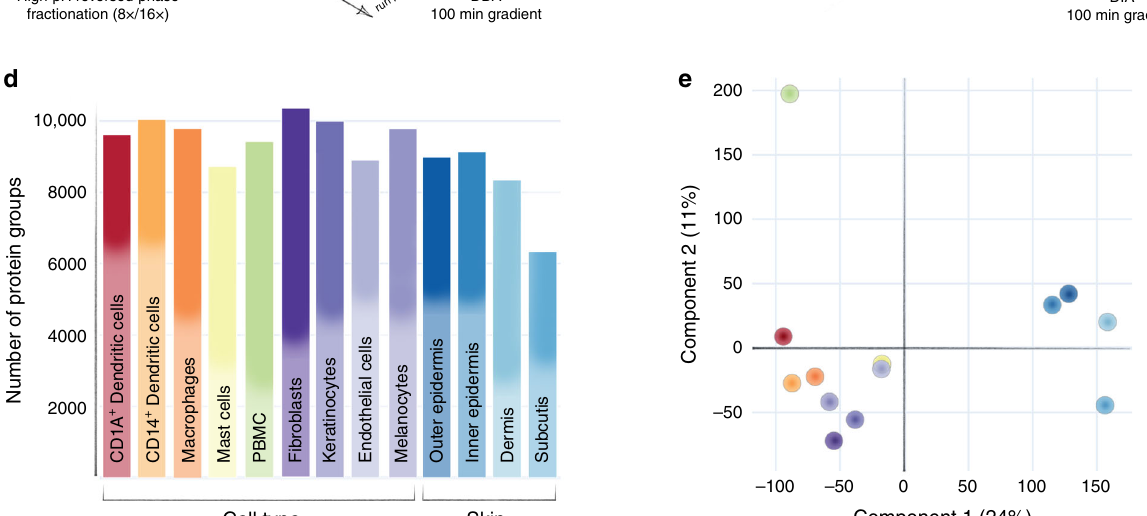
Fig. 1 In-depth MS-based proteomic analysis of skin layers and its cellular subsets. a Work fl ow for measuring the skin proteome including skin layers, cultivated keratinocytes, and fi broblasts and FACS-sorted melanocytes, endothelial cells, and immune cells. b High-resolution MS analyses of fractionated, pooled samples in data-dependent acquisition mode (DDA) and subsequent ( c ) single-run analyses of three to six biological replicates in data-independent (DIA) acquisition mode. d Number of protein groups for each major cell subset and skin layers based on pooled samples (one independent experiment) for cell subsets and skin layers, respectively examined over one independent experiment (CD1A + dendritic cells ( N = 3), CD14 + dendritic cells ( N = 3), macrophages ( N = 4), mast cells ( N = 6), fi broblast ( N = 5), keratinocytes ( N = 5), endothelial cells ( N = 4), melanocytes ( N = 5), skin layers ( N = 5). A total of 10,701 protein were identi fi ed. e Principal component analysis (PCA) of all proteomes from skin layers, primary cells and immune cell types. Color code from panel ( d ). The fractionated proteome of PBMC (green dot) was included as library for skin-associated T cells. Component 1 and 2 account for 24 and 11% of the total data variation,